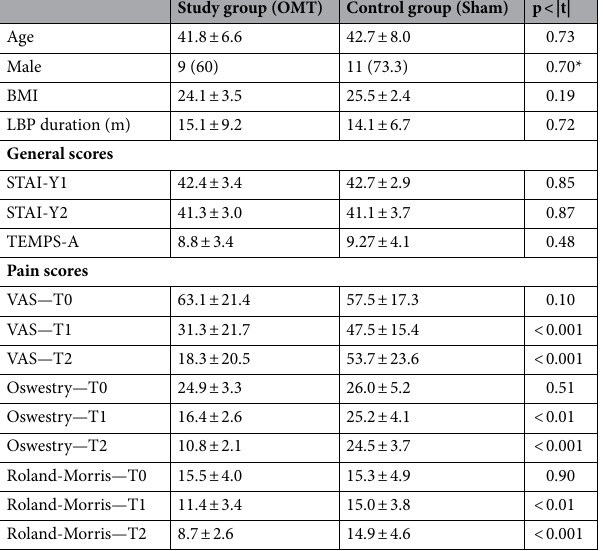
Table 1. Clinical characteristics of study population. Numbers in table are mean ± SD or *N(%). P values from Student t test and *Chi square. BMI body mass index, LBP low back pain, VAS visual analogue